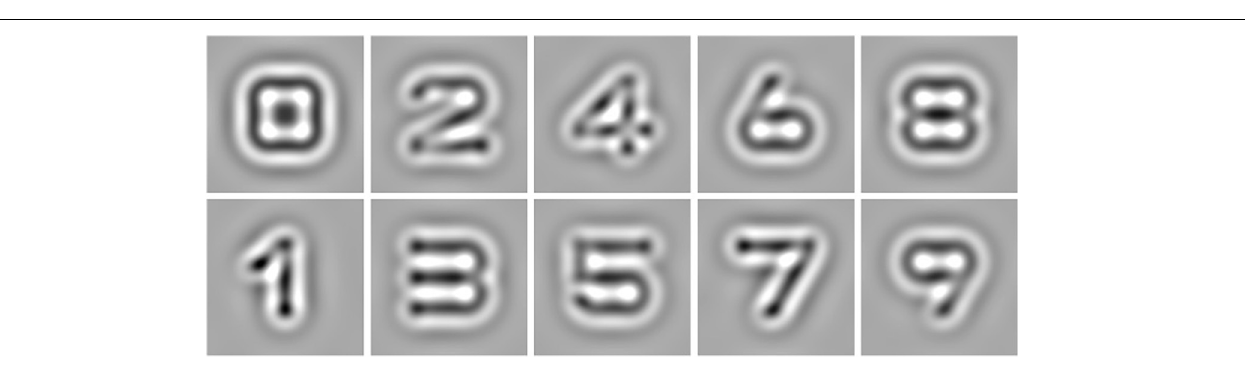
FIGURE 2 | Band-pass filtered digits used in the qCSF test.